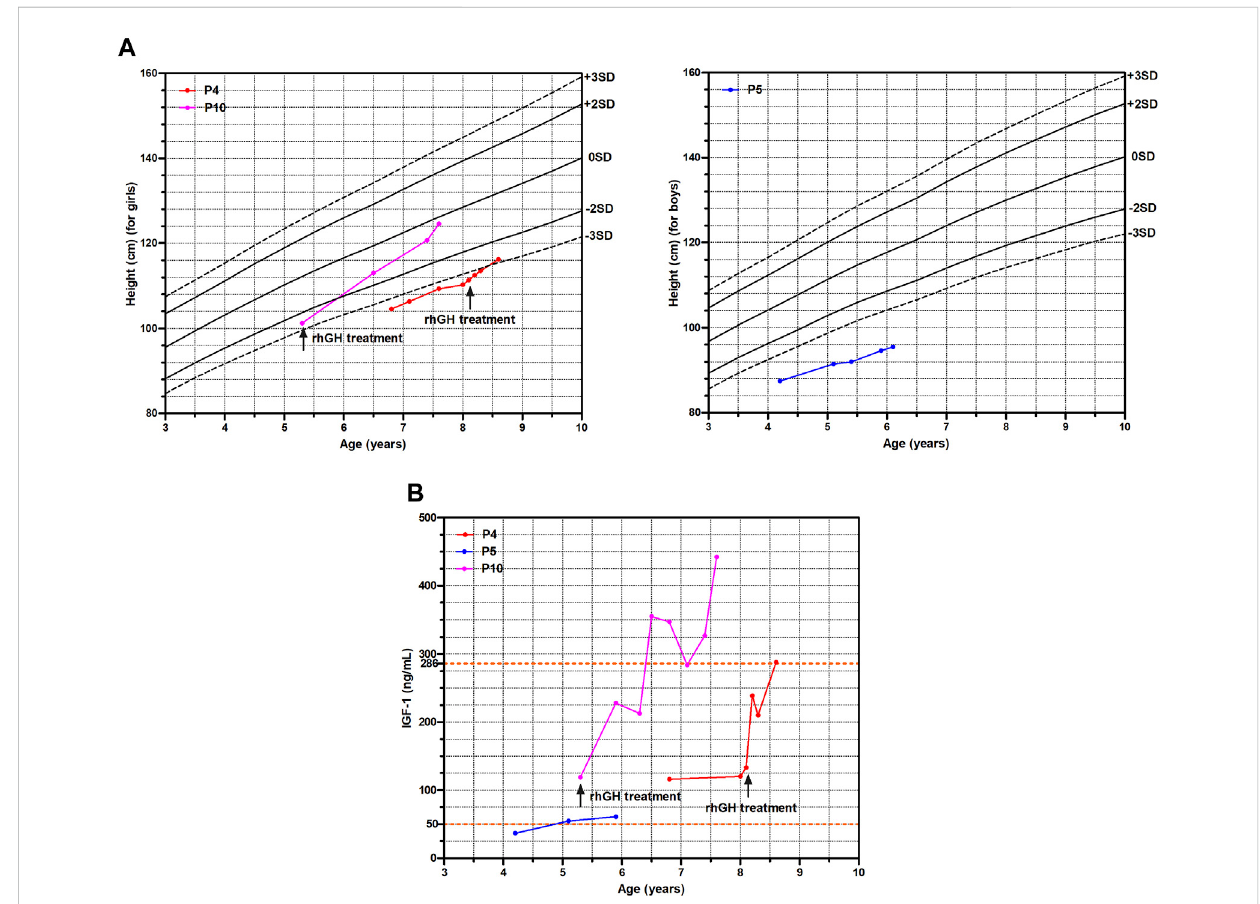
FIGURE 2 The growth curve and IGF-1 levels of three WSS children. (A) Growth curve. (B) IGF-1